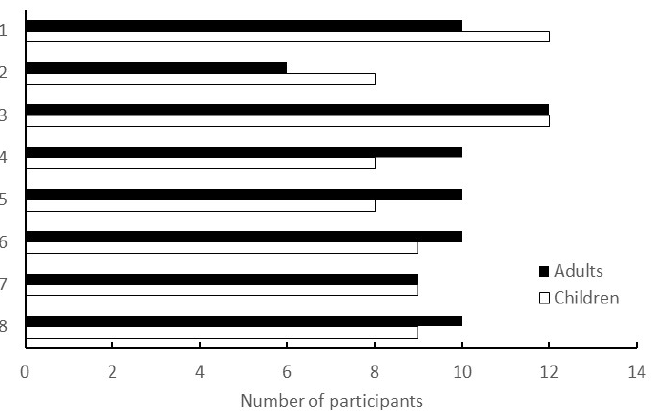
Figure 3. Number of participants in the workshop. The vertical axis represents the number of times the workshop was conducted; the horizontal axis represents the number of participants at each workshop. Children were dependents of adults and did not participate in the workshops; they were left at the attached childcare facility. left at the attached childcare